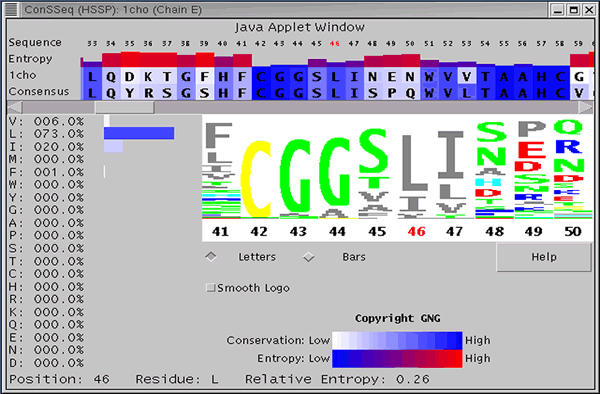
Sequence Conservation in SMS ConSSeq. ConSSeq window where the amino acid sequence of 1cho, chain E is aligned with a consensus sequence as found in HSSP and, entropy histogram color and size coded with respect to the calculated degree of conservation. The size of sequence letters in the "logo" follows the same degree of conservation, while color coding is the same as in SMS sequence frame. Leu_46 is highlighted by sequence number 46 colored red.